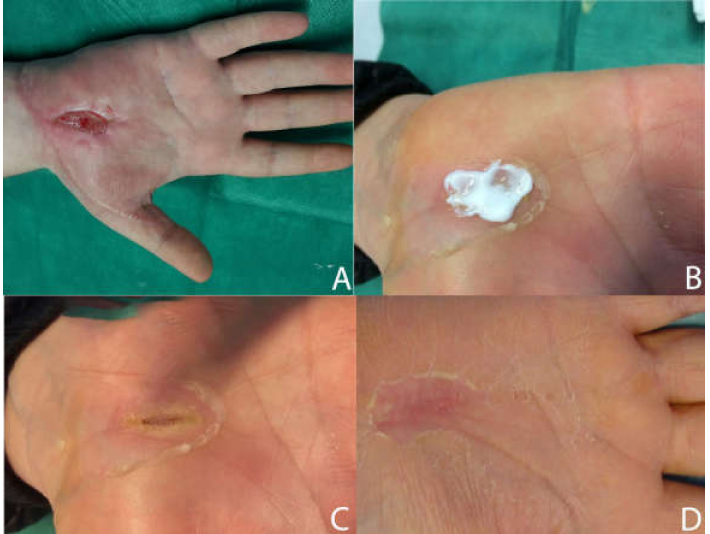
Figure 5. Post-traumatic case. AC, 52 y/o. Presence of periwound inflammation signs and Class 3 periwound tissue according to HPS classification. Appearance of the wound after injury ( A ). Application of the Connettivina Plus ointment ( B ). Wound aspect after 2 weeks ( C ) and final aspect with complete reepithelialization after 8 weeks ( D